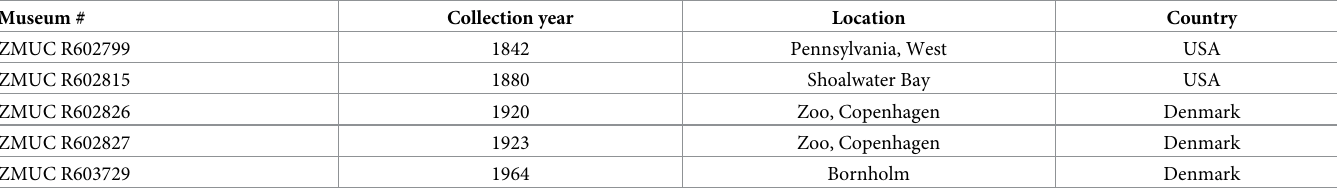
Table 1. Five specimens of Thamnophis sirtalis included in this study.